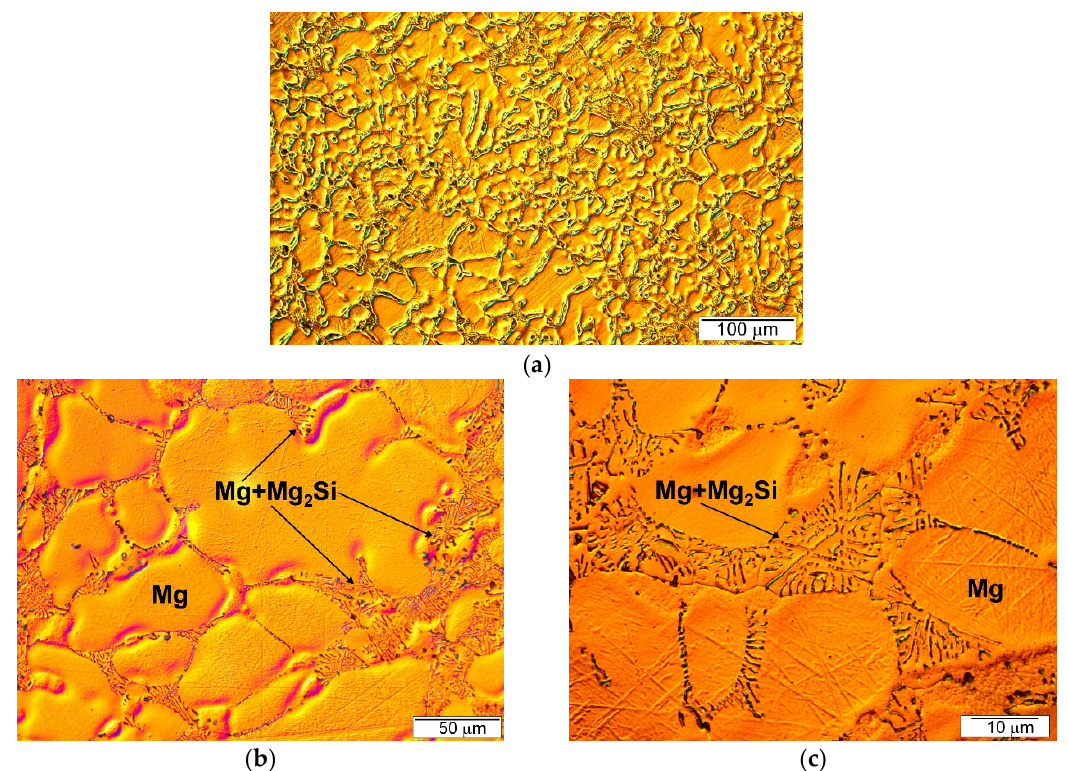
Figure 3. Microstructure of Mg/Mg 2 Si–HO composite ( a – c ) three micrographs taken at different magnifications for Mg/Mg2Si–HO.